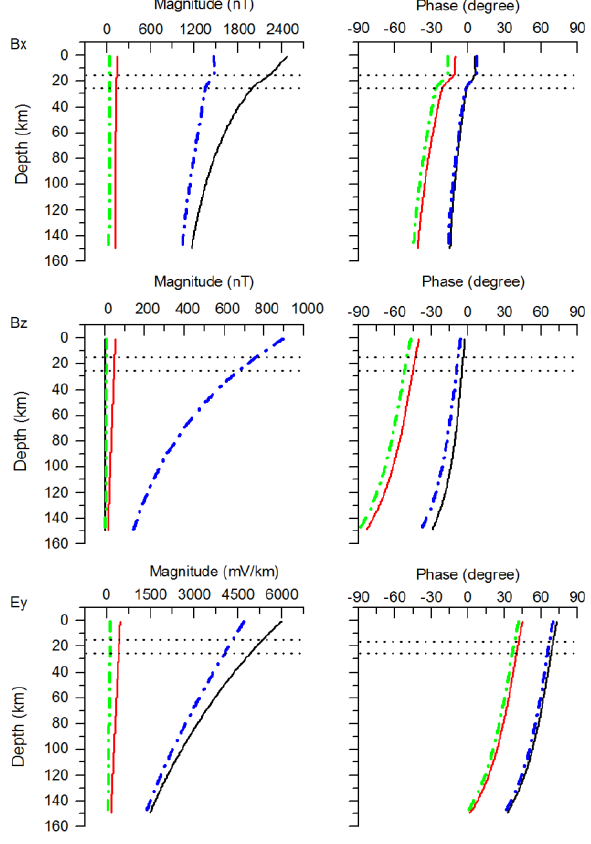
1 Fig. 7. The magnitude and phase variations of the electric and mag- Figure 7. The magnitude and phase variations of the electric and magnetic fields with depth 2 netic fields with depth at x = 0 (black), x = 100 (blue dot-dashed), x = 800 (red) and x = 1500km (green dot-dashed) for a layered at x=0 (black), x=100 (blue dot-dashed), x=800 (red) and x=1500 km (green dot-dashed) for a 3 earth conductivity model of Quebec are shown for a 1km line cur- rent located at x = 0, 100km above the surface and having a period layered earth conductivity model of Quebec are shown for a 1 km line current located at x =0, 4 of 300s. The computations are based on 100 km above the surface and having a period of 300 s. The computations are based on FEM. 5 6 7